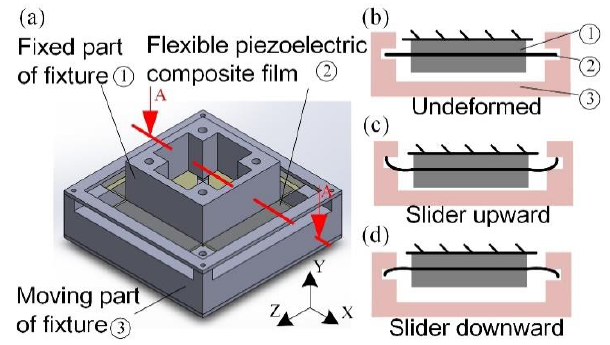
Figure 2. Schematic diagrams of the piezoelectric power-generation component. ( a ) Piezoelectric- power-generation component; ( b ) slider located at the equilibrium point; ( c ) slider upward; ( d ) slider downward.